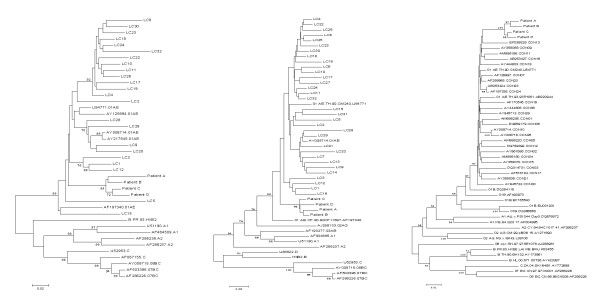
Phylogenetic analyses of HIV-1 genome of the four patients, controls and reference sequences. Sequences LC1 to LC32 in env tree and gag tree indicate randomly selected unrelated CRF01_AE local control sequences. Sequences CON01 to CON30 in pol tree indicate randomly selected CRF01_AE control sequences from NCBI GenBank. The HIV-1 reference sequences retrieved from NCBI GenBank. Phylogenetic trees based on the partial sequence of the env C2V3V4 region (left), gag p17/p24 junction (middle) and a partial of pol gene (right) of HIV-1 genome were constructed by using the neighbor-joining method under the Kimura two-parameter model. The number at the node indicates the bootstrap values.